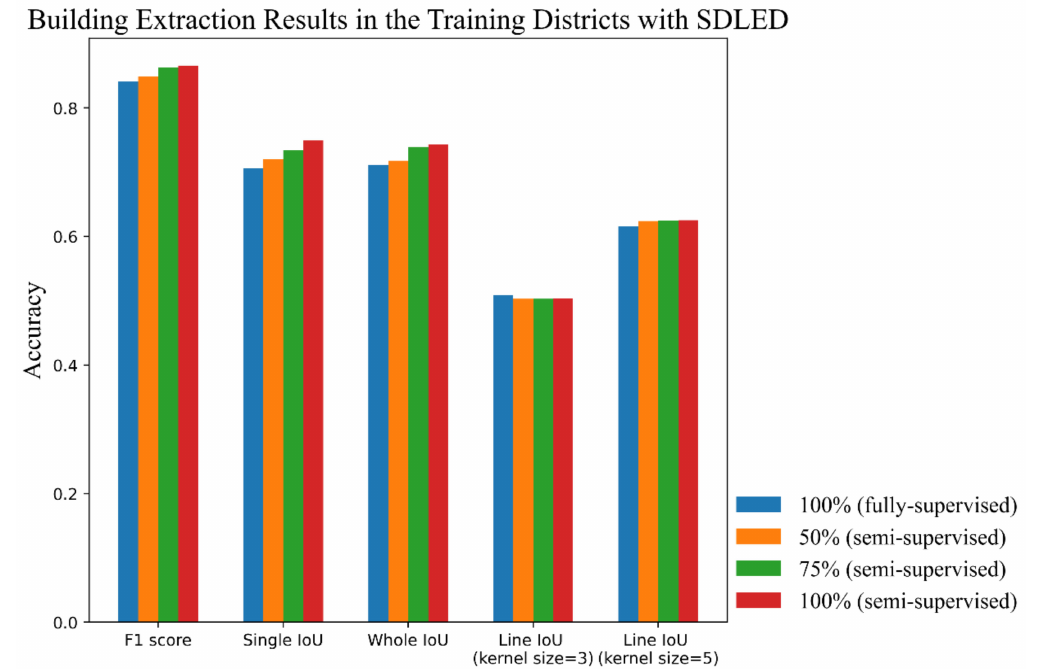
Figure 6. Precision evaluation results for the effect of edges in SDLED. Table 2. Precision evaluation results for the effect of edges in